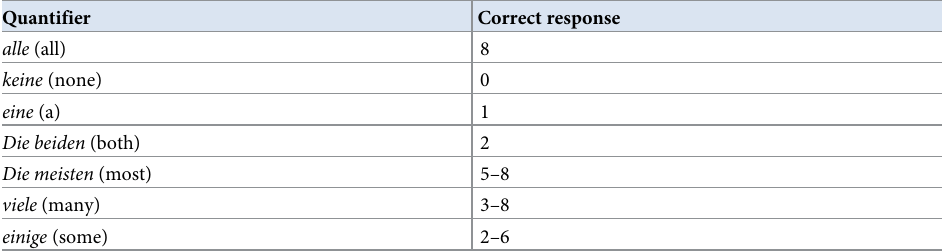
Table 2. Definitions of ‘correct’ (i.e., adult-like) responses for each quantifier (maximum number of tokens = 8).